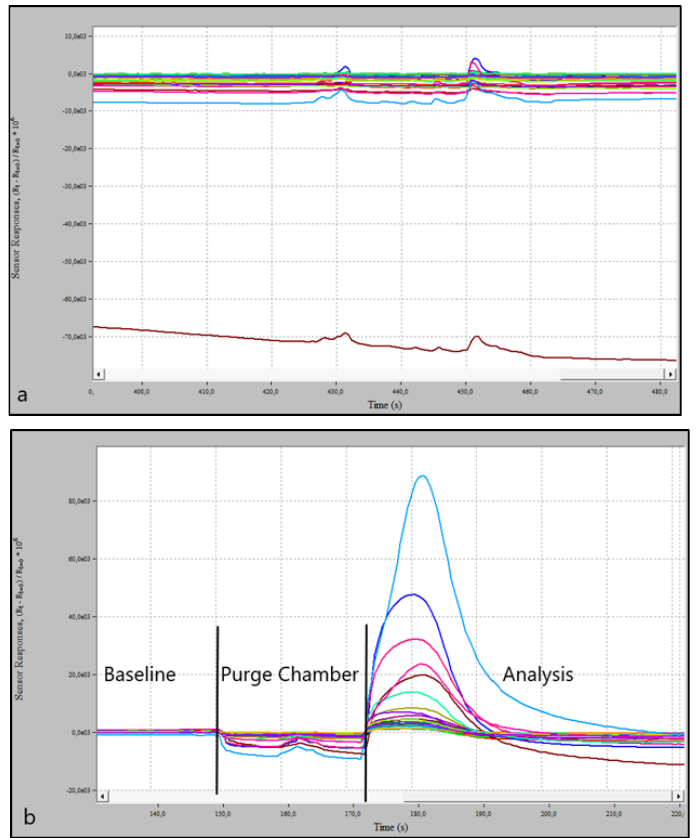
Figure 4. Graphical representation of the sensors responses curves during the analysis. ( a ). Baseline sensor representation. ( b ). Analysis of Renal Cancer Sample. We can see the baseline sensor representation, purge chamber with negative pressure and analysis of the sample . The colored lines represent the response of the 32 sensors.